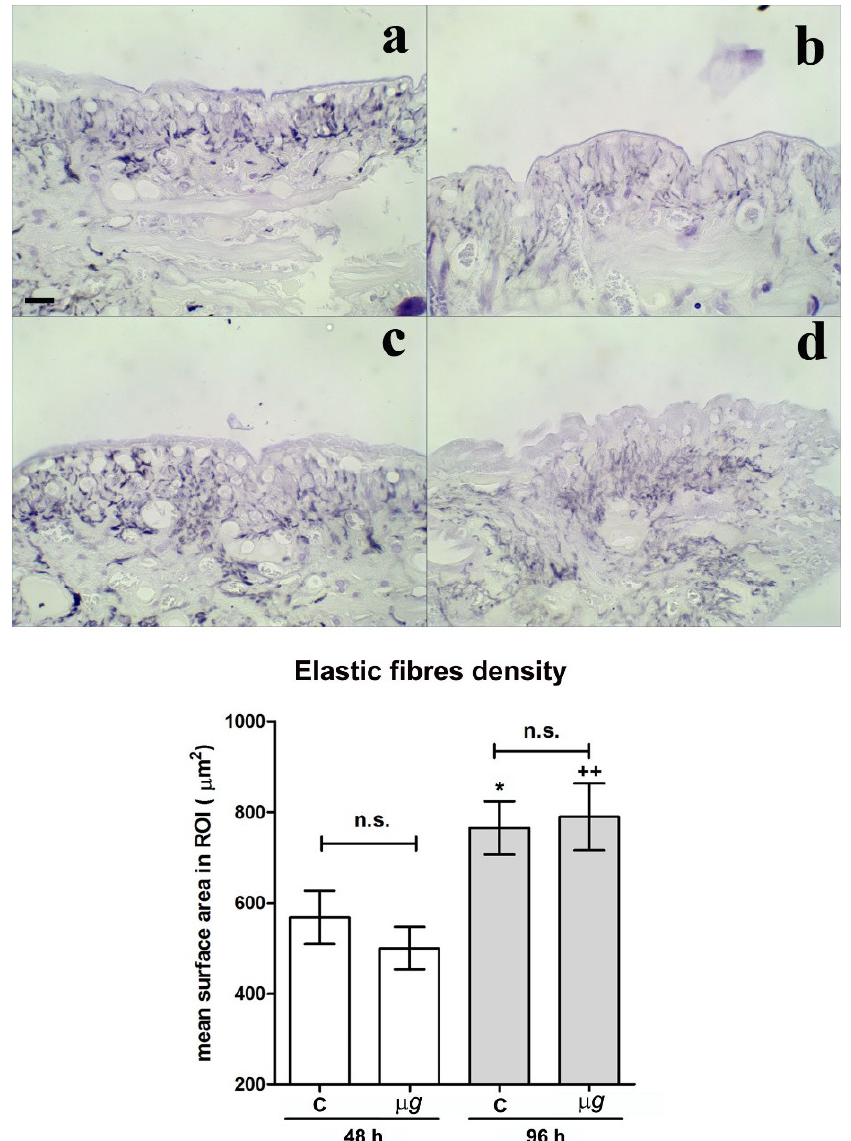
Figure 3. Effect of modeled μg on in vivo model of sutured wound healing ( Hirudo medicinalis ): elastic fibre content in the connective tissue at the wound site. Light microscopical features and morphometric quantitation of paraldehyde fuchsin-stained elastic fibres at the wound site after 48 h and 96 h exposure to modeled μg ( b , d ), compared with 1 × g controls ( a , c ). In the graph C = 1 × g ; bar = 20 μm; * p < 0.05 vs. C-48h, ++ p < 0.01 vs. μg -48 h, ( n = 3); n.s. = not